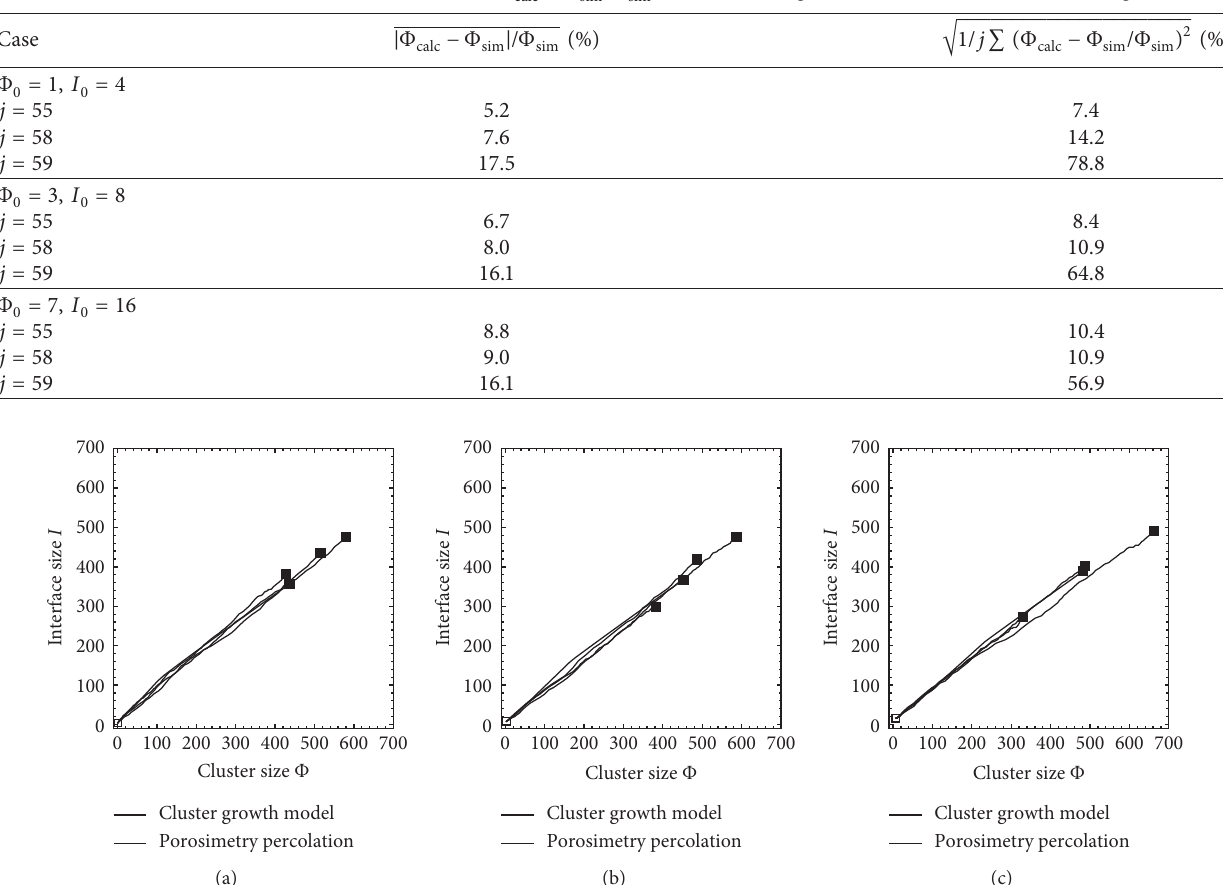
Figure 11: Simulated and calculated evolutions on the ( Φ , I ) plane for (a) single site ( Φ � 3, I � 8), and (c) maximum perimeter heptomino ( Φ ( Φ 0 0 growth model and the thin lines are evolutions computed with individual porosimetry percolation simulations. The empty squares and full squares correspond to the starting and fully evolved clusters,